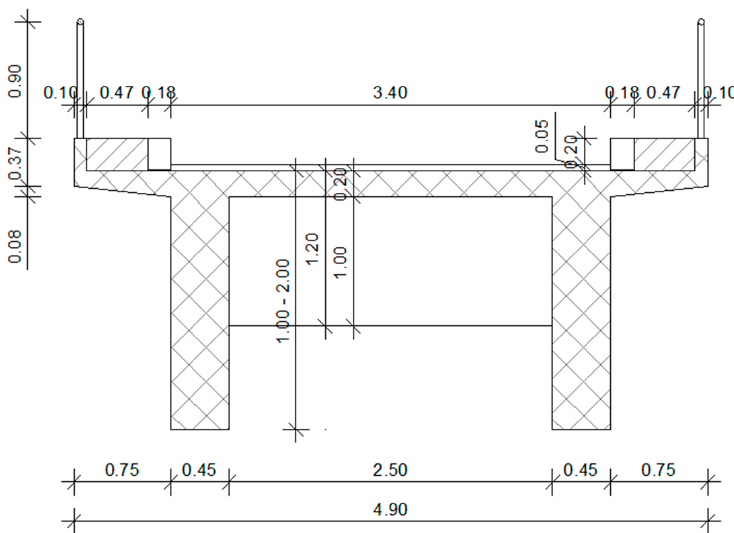
Figure 14. The longitudinal section of the bridge 2.